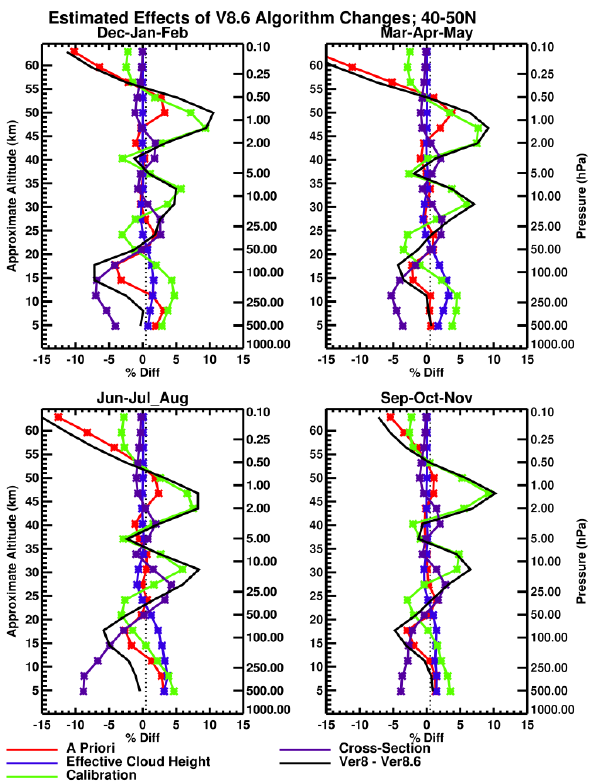
Figure 3. Same as Figure S4, but for the 40-50N latitude band. Again, the largest differences between the V8 and V8.6 algorithms are due to the updated calibration and a priori, but the cross-section also causes notable differences below 100 hPa at 40-50N. Cloud-height climatology differences vary seasonally at this latitude, with a larger influence in the NH spring-summer months.